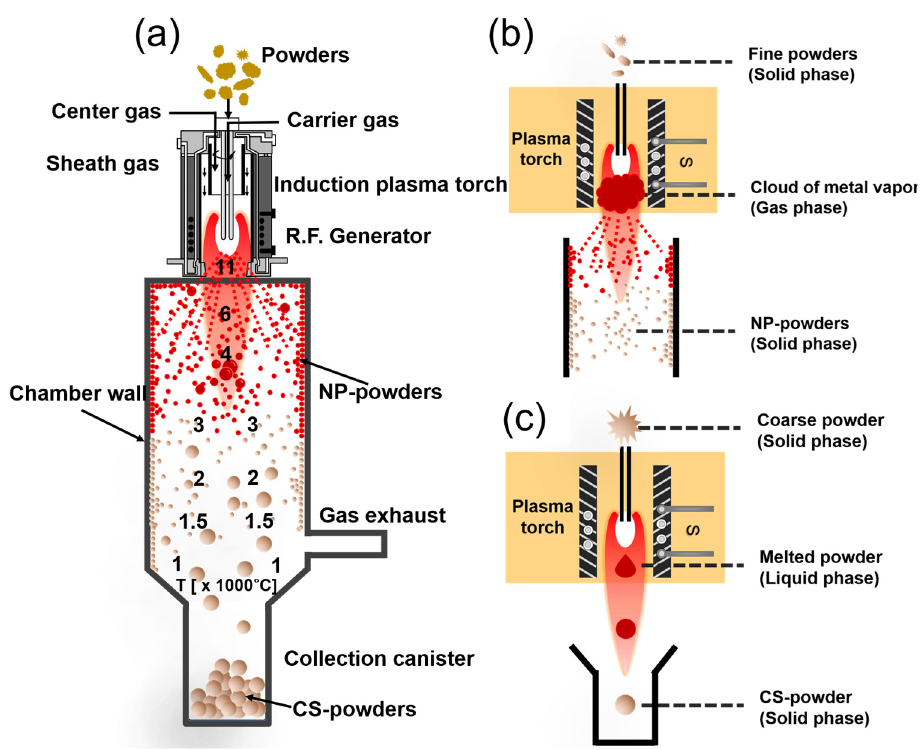
Figure 11. Formation mechanism of multiscale copper powders: ( a ) RF plasma system, ( b ) formation of the NP-powder and ( c ) CS-powder.